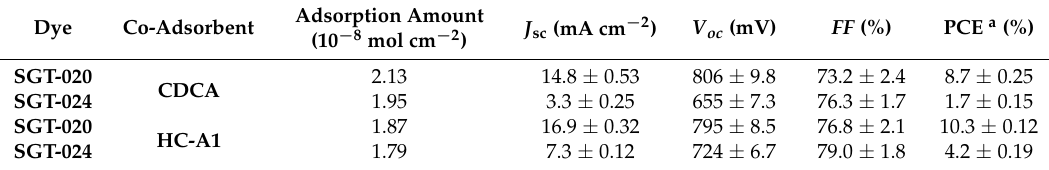
Figure 4. ( a ) Current-voltage characteristics of the SGT-020 and SGT-024 -based DSSCs and ( b ) the corresponding IPCE spectra under 100 mW cm − 2 simulated AM 1.5G solar light. Table 2. Photovoltaic parameters of the SGT-020 and SGT-024 -based DSSCs under 100 mW cm − 2 simulated AM 1.5G solar light.